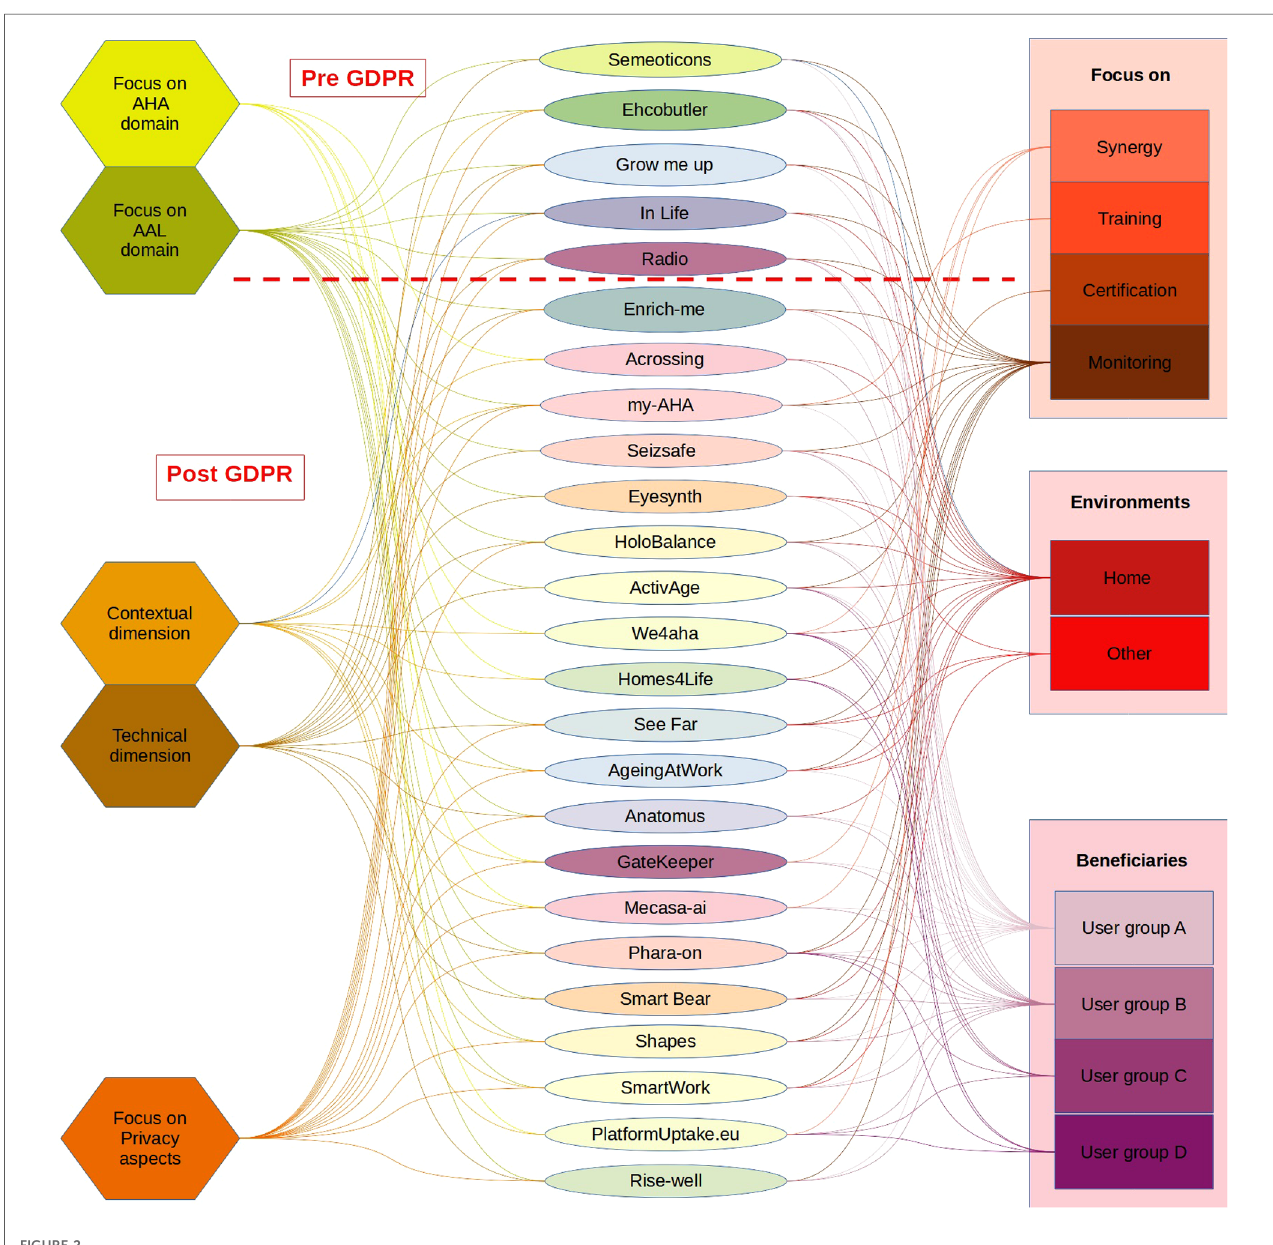
FIGURE 2 Graphic representation of the characteristic of the